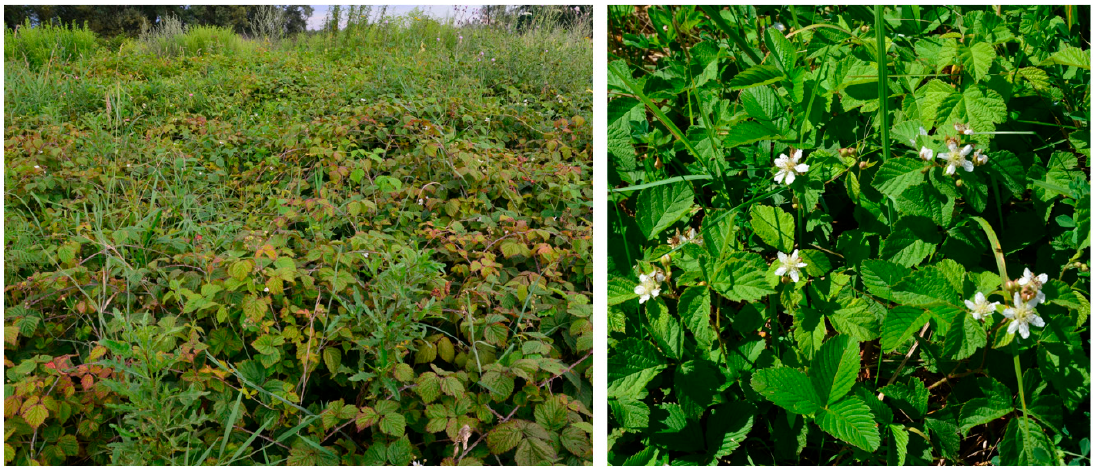
Figure 1. Images of Rubus caesius taken at the study area acquired in summer (second campaign,